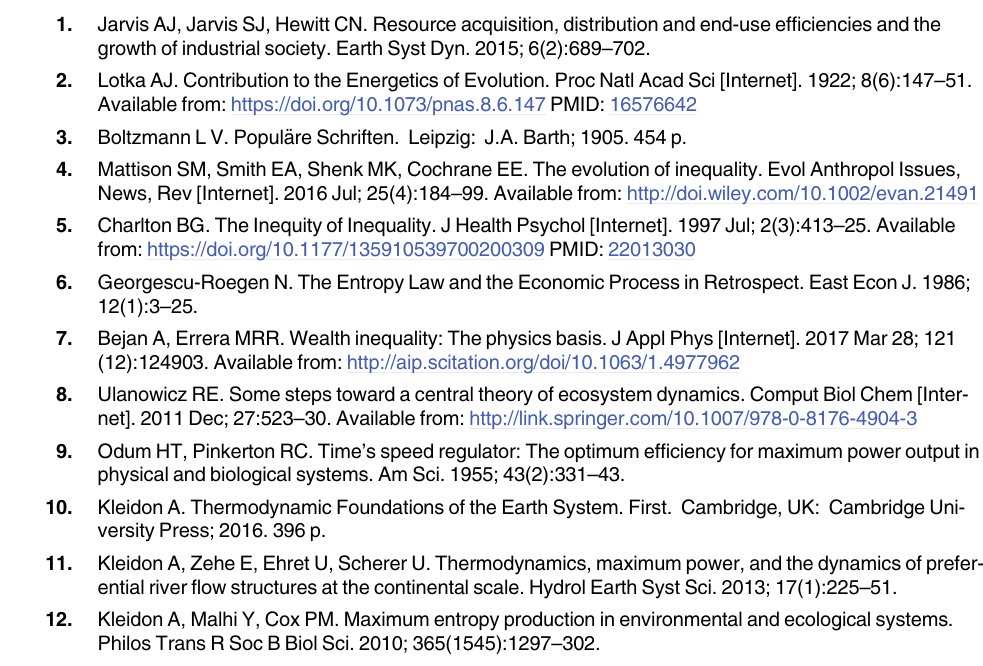
‘evolved branching’ networks. The units are generalised units of power, rather than units only applicable to a specific type or types of resource distribution network. S3 Fig. Non-normalised version of Fig 7, showing final power of consumers ( P level of the ‘fully branched’ network, as related to the resource flow to each consumer ( I The units are generalised units of power and resource flow, rather than units only applicable to a specific type or types of resource distribution